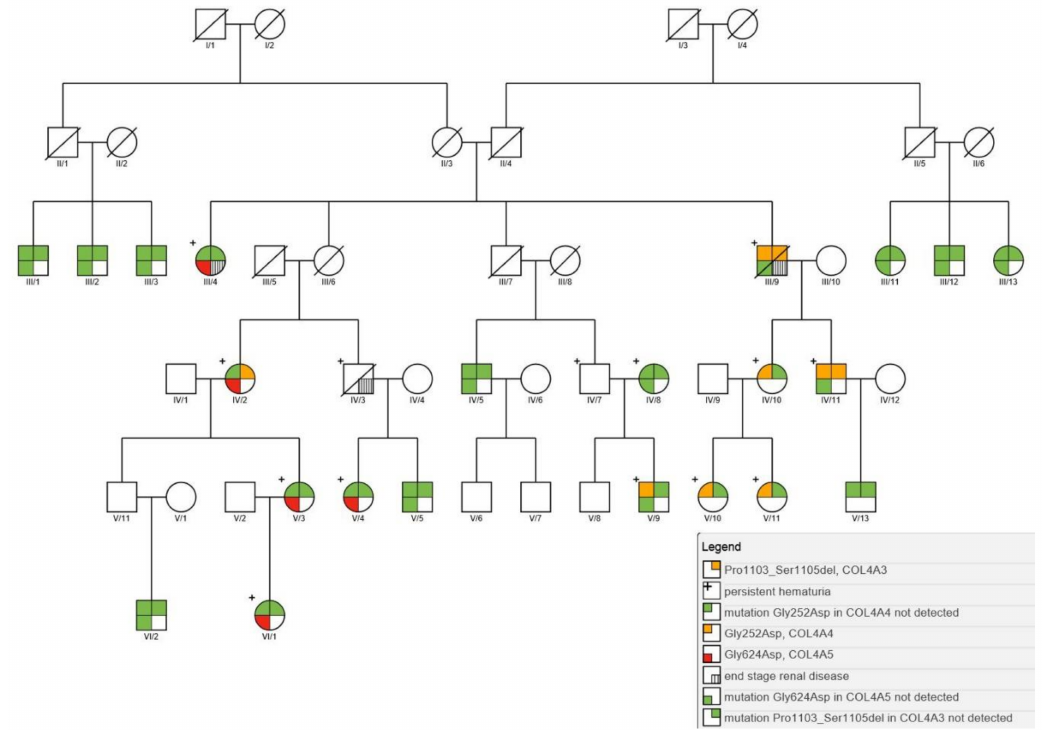
Figure 2. Pedigree tree of the Galiˇcnik family having digenic autosomal inheritance with mutation in COL4A3 and COL4A4 in cis and X-linked COL4A5